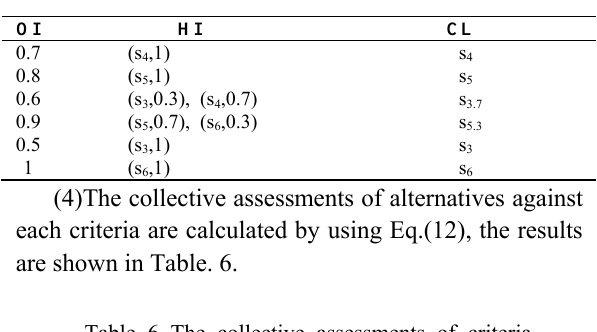
Table 5. Unified results of crisp values.